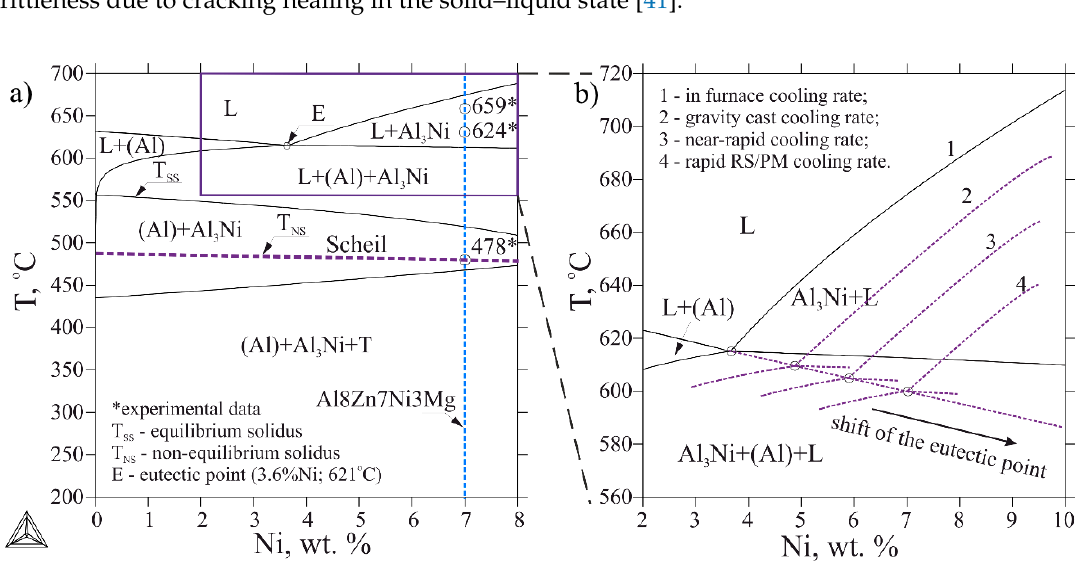
Figure 2. ( a ) Polythermal section of a Al-Zn-Mg-Ni system at 8%Zn and 3%Mg with marked non-equilibrium solidus calculated by Scheil–Goulliver simulation and ( b ) schematic representation of the solidification path shift as a result of an increase in the cooling rate.